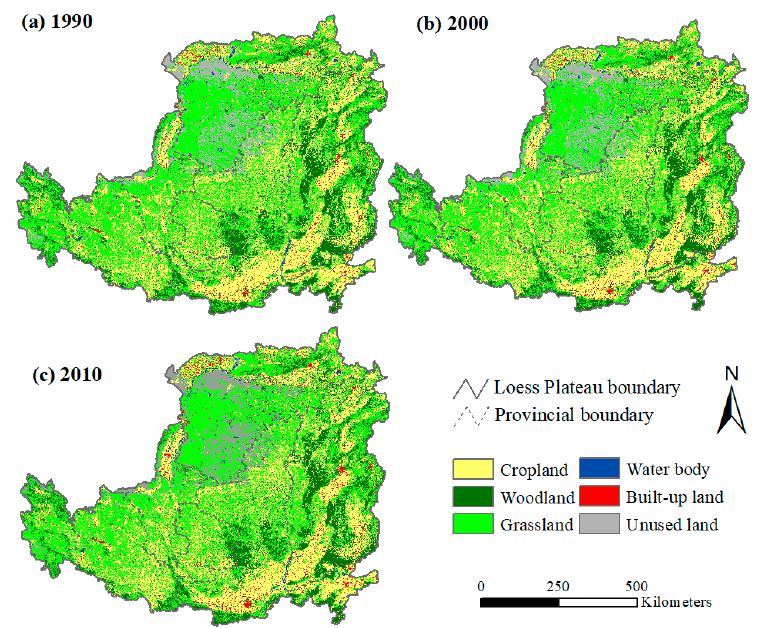
Figure 2. The spatial distribution of land use and land cover in the Loess Plateau in ( a ) 1990, ( b ) 2000, and ( c ) 2010.